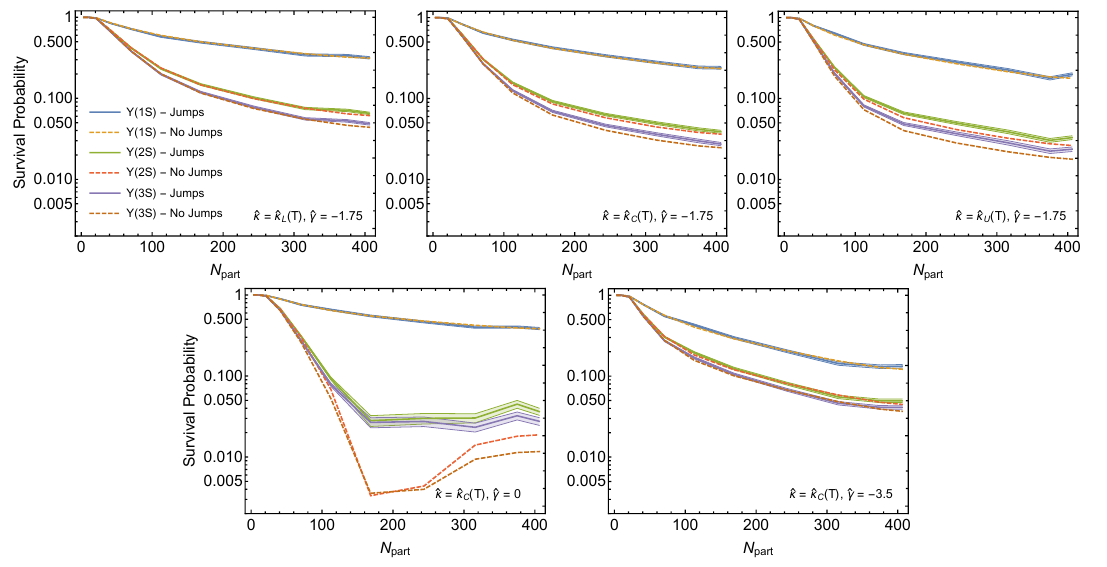
Figure 7 . Survival probability of S -wave bottomonium states versus N part in the presence of quan- tum jumps (continuous lines; these are the same curves as in figure 6, but now with a logarithmic scale for the probabilities) and without quantum jumps (dashed